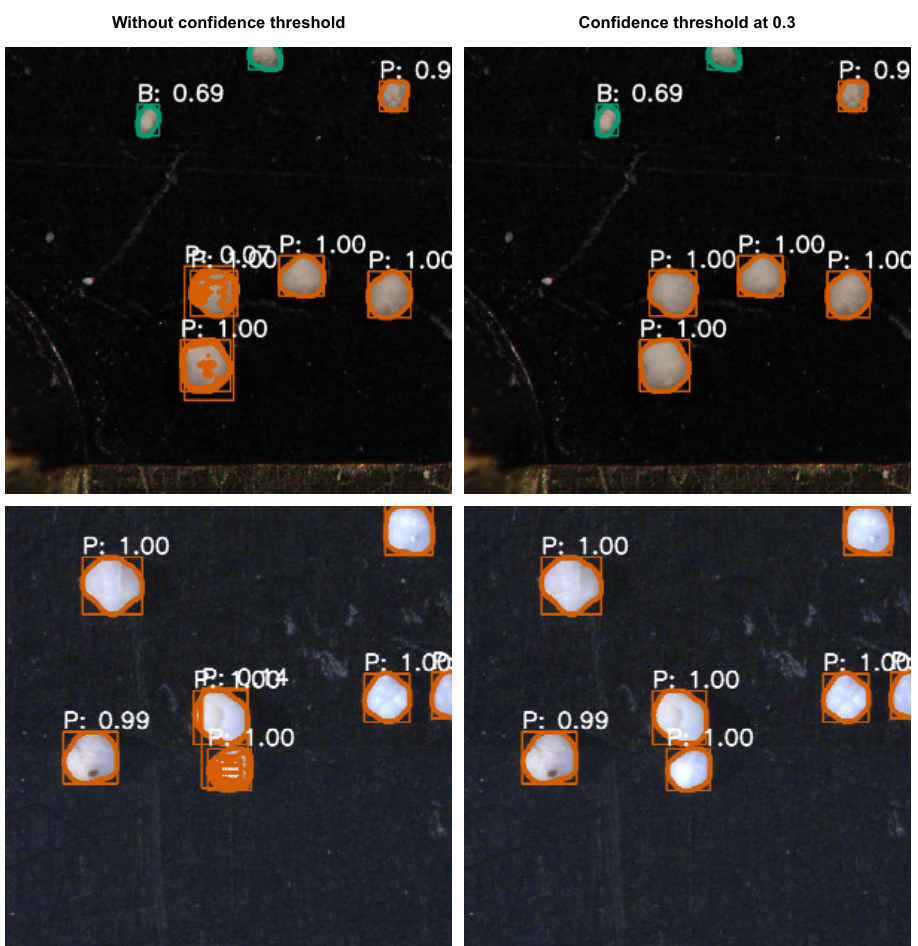
Figure A1. Examples of predicted bounding boxes and segmentation masks for the “planktic” class. ( Left column ): Overlapping predictions can be seen near the middle of both images. The confidence score for the overlapping predictions with low-quality masks is significantly lower than the high-quality predictions. We can also see that some smaller objects in the top image have been misclassified as the “benthic” class. ( Right column ): The overlapping predictions have been removed by thresholding the confidence score at